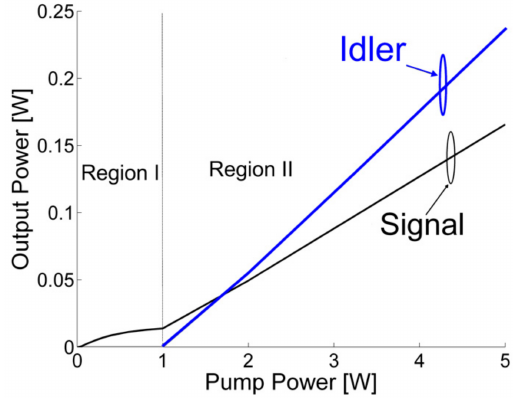
Figure 5. An example dependence of the signal and idler power on the pump power for a cascade chalcogenide glass fiber laser doped with dysprosium ions. Figure was adapted from